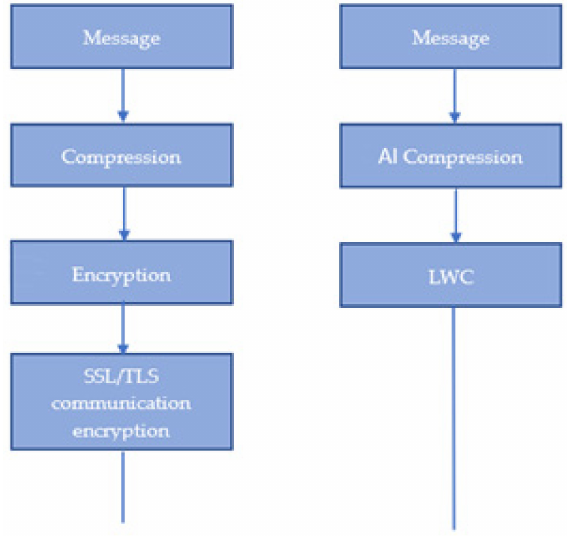
Figure 1. Standard SSL/TLS and suggested solution.